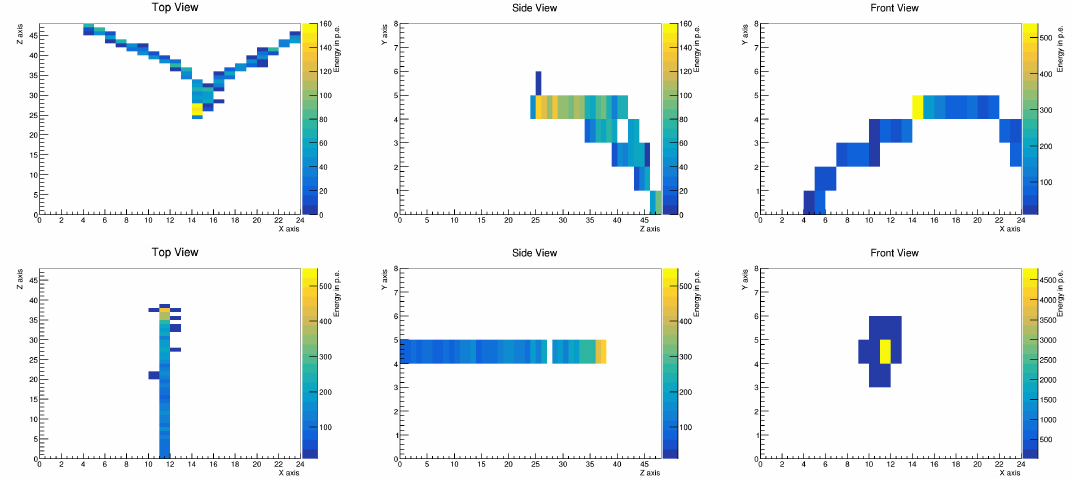
Figure 123. Event displays showing a photon conversion ( top ) and a stopping proton ( bottom ) from data collected at the 2018 test beams at the CERN T9